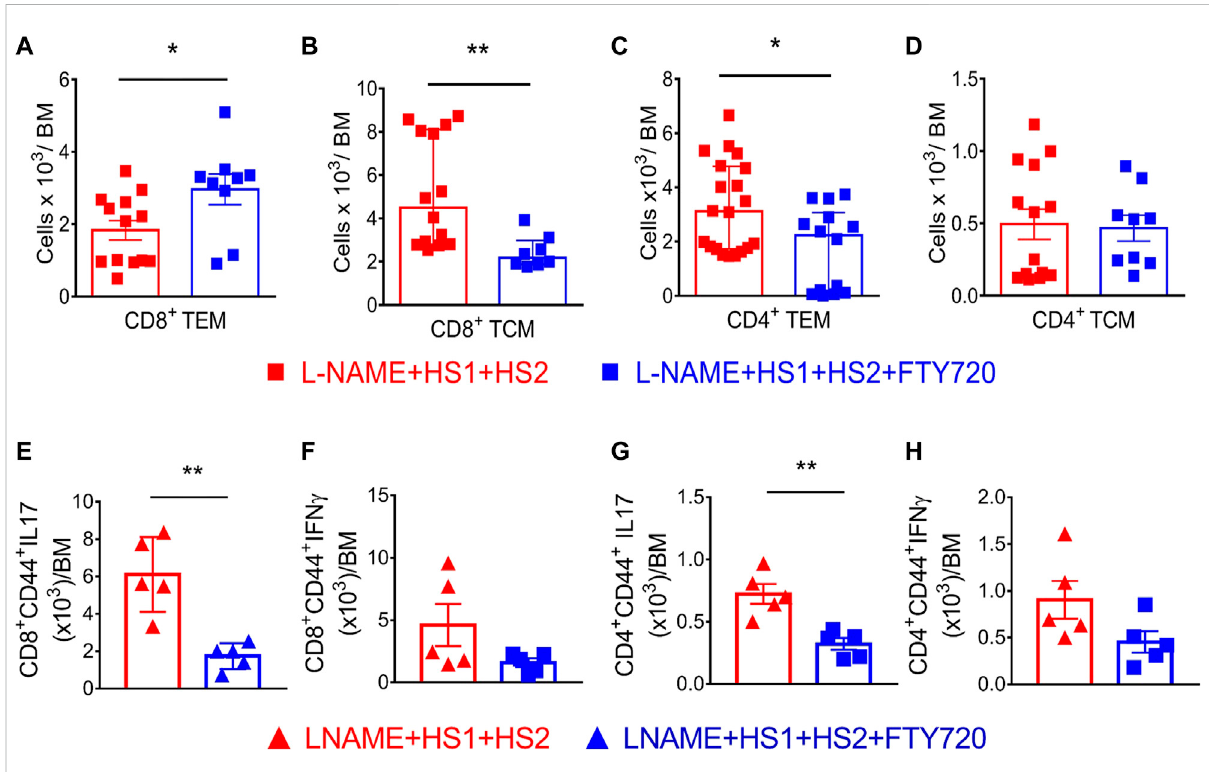
FIGURE 4 FingolimodlocksCD8 + andCD4 + TEMandTCMcellsinthebonemarrowandattenuatestheirsecretionofin fl ammatorycytokines. (A – D) Flow cytometric quanti fi cation of total CD8 + (A&B) and CD4 + (C&D) TEM and TCMsinglengel-cell suspensions of the bone marrow from WT mice followingtheL-NAME+HS1+HS2± fi ngolimodprotocol.N=8 – 20mice/group.Normallydistributeddataareexpressedasmean±SEM(panelA&D); not normally distributed data are expressed as median ± IQR (panel B&C) (Supplementary Table S2). (E – H) Intracellular staining showing the levels of secreted IL-17 and IFN- γ by CD4 + and CD8 + effector memory cells isolated from mice that received L-NAME + HS1+HS2± fi ngolimod. N = 5 mice/group. All data are normally distributed expressed as mean ± SEM (Supplementary Table S3). p -values calculated by unpaired t -test were shown. * p < 0.05, ** p <